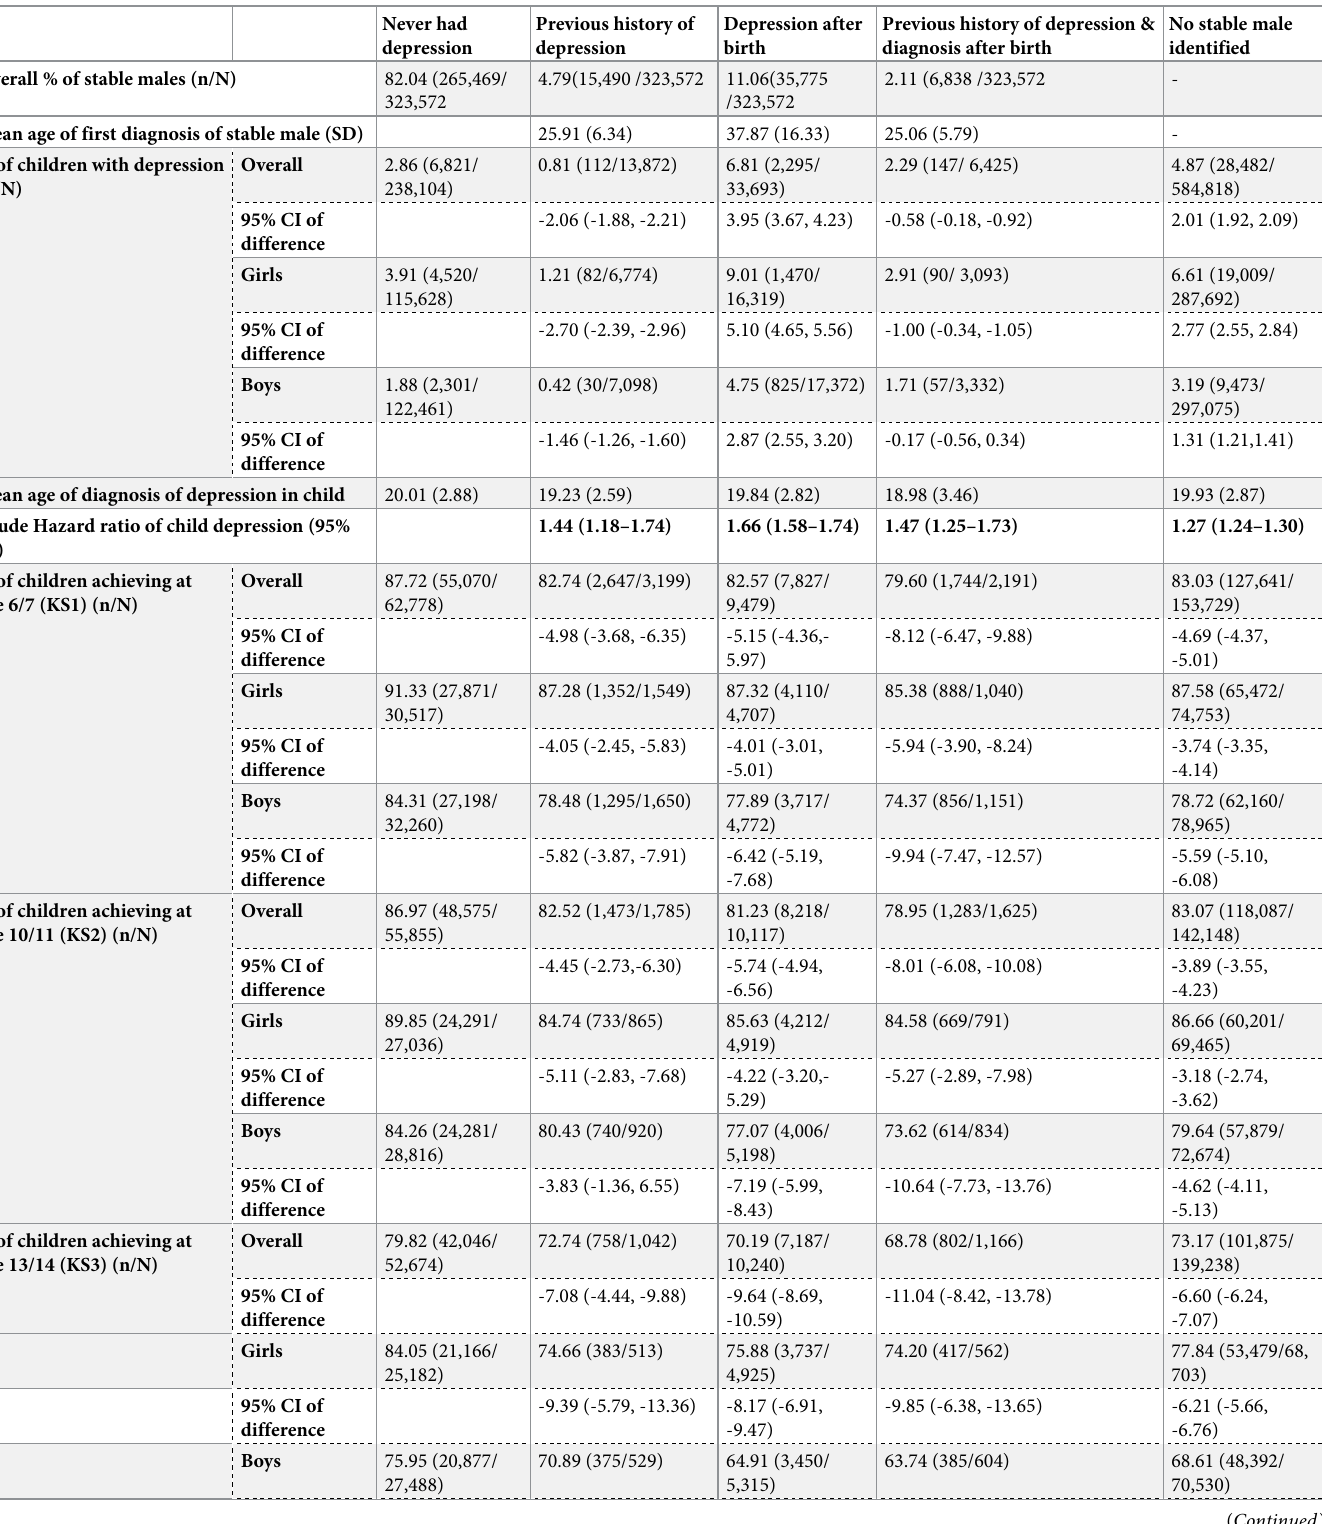
Table 2. Descriptive characteristics of stable male depression, offspring depression and offspring educational